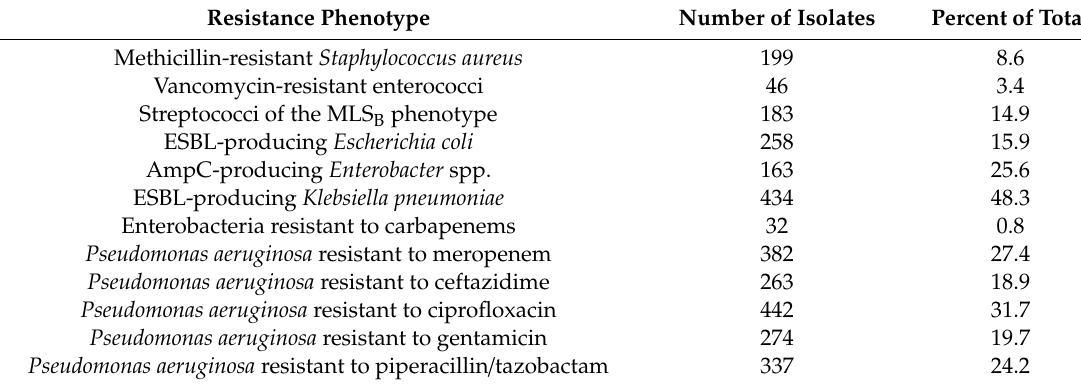
Table 2. Bacterial species isolated from infected decubitus ulcers, leg ulcers and surgical